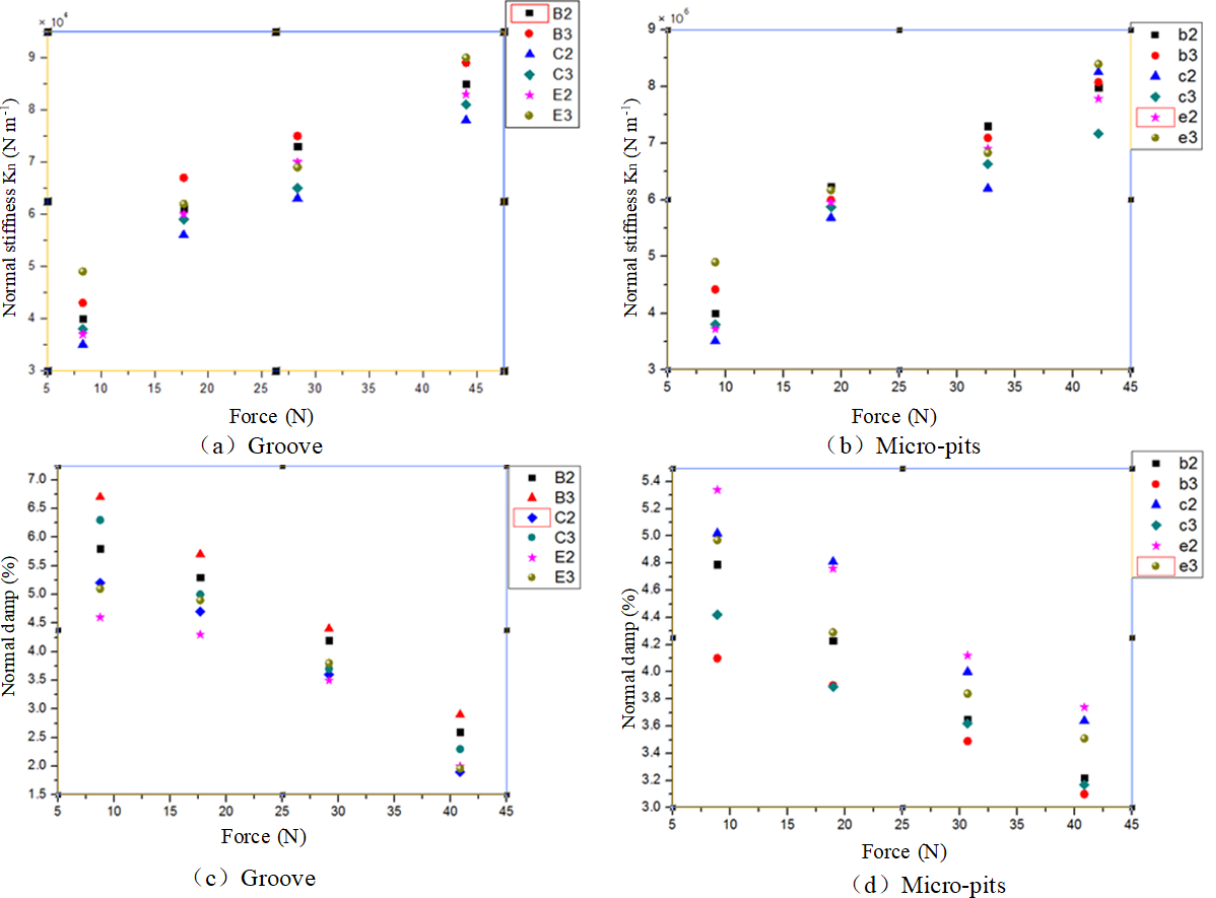
Figure 18. (a, b) The impact of exciting force on the normal stiffness (groove and micro-pits). (c, d) The impact of exciting force on the normal damp (groove and